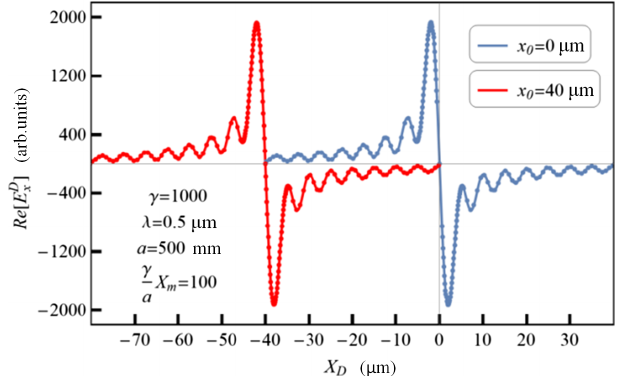
FIG. 5. Real part of the single particle OTR field in the detector plane for two different impact parameters. The parameter set used for the calculation is shown in the insert.